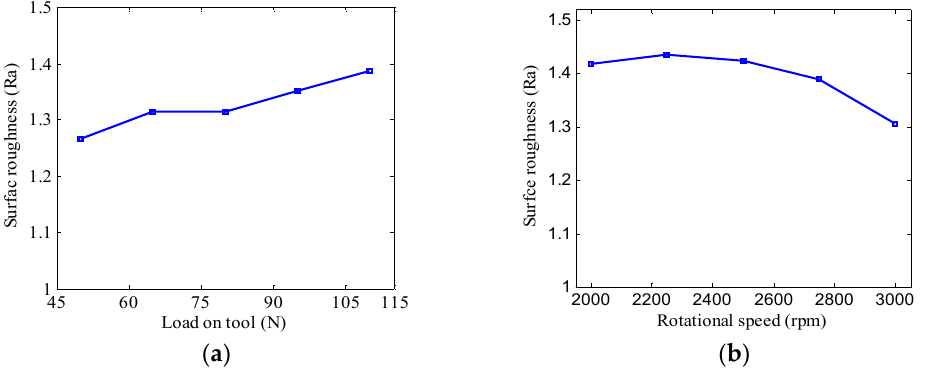
Figure 11. The surface roughness of the polished sample with various process parameters in DHDP; ( a ) Tool load; ( b ) Rotational speed.